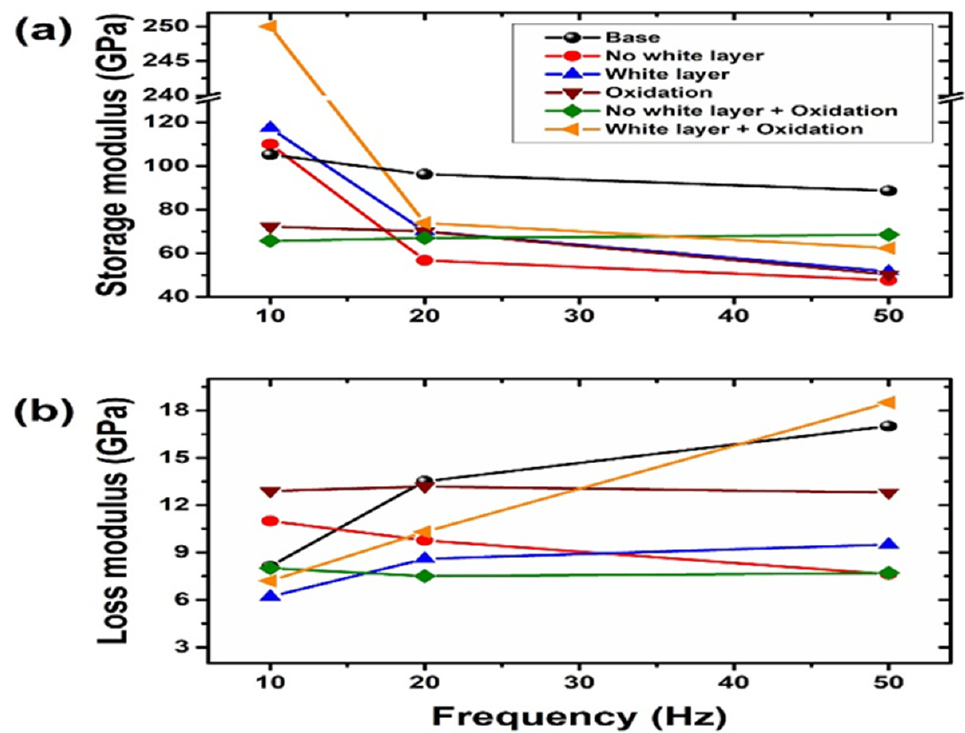
Figure 7. ( a ) Storage modulus and ( b ) loss modulus as a function of cyclic loads of 10, 20 and 50 Hz. (Reprinted from Surface & Coating Technology, 385, J.C. Díaz-Guillén, M. Naeem, H.M. Hdz-García, J.L. Acevedo-Davila, M.R. Díaz-Guillén, M.A. Khan, Javed Iqbal, and A.I. Mtz-Enriquez, Duplex plasma treatment of AISI D2 tool steel by combining plasma nitriding (with and without white layer) and post-oxidation, 125420, Copyright (2020), with permission from Elsevier.)